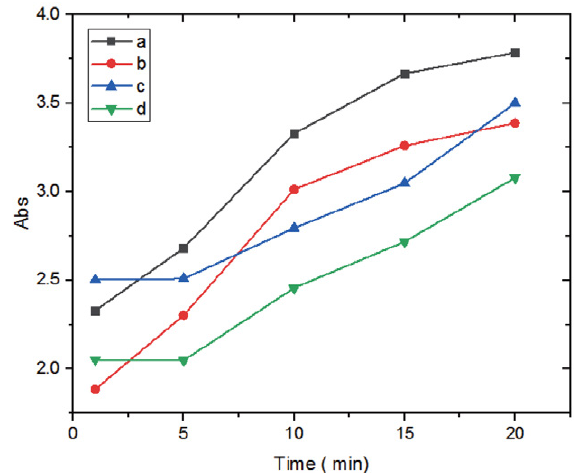
Figure 5. The effect of contact time on drug adsorption a, (Dosage = 1.6 gr / L, λ max = 482) b ( Dosage = 1.6 gr / L, λ max = 290) c (Dosage = 0.8 gr / L, λ max = 482) d (Dosage = 0.8 gr / L, λ max = 290)